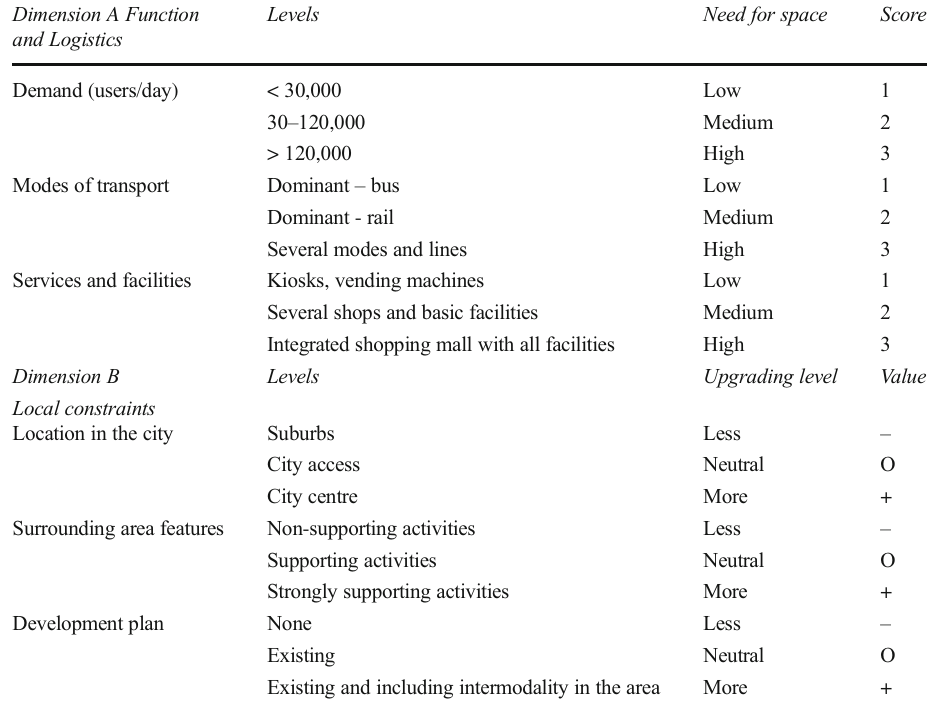
Table 1 Interchange Dimensions: Function and Logistics, Local